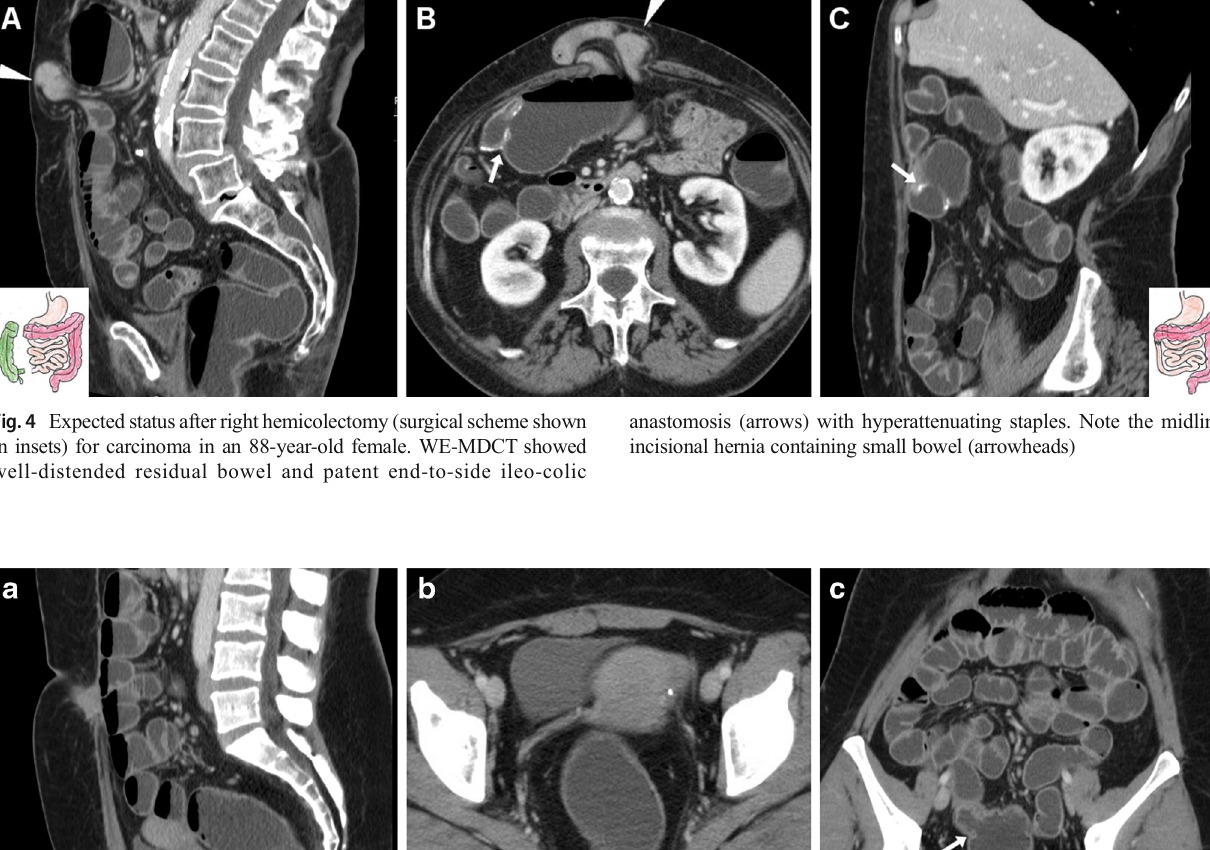
thin walls, normal mesorectal space, patent end-to-side ileo-rectal anas- tomosis (arrow in c ) and distended jejuno-ileal